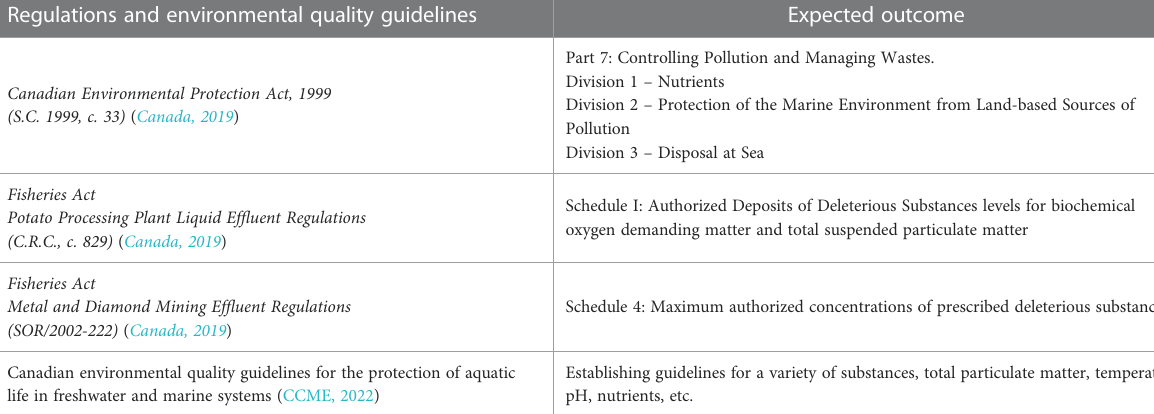
TABLE 2 Examples of regulations and environmental quality guidelines (Canada, 2019; Canada, 2021; CCME,